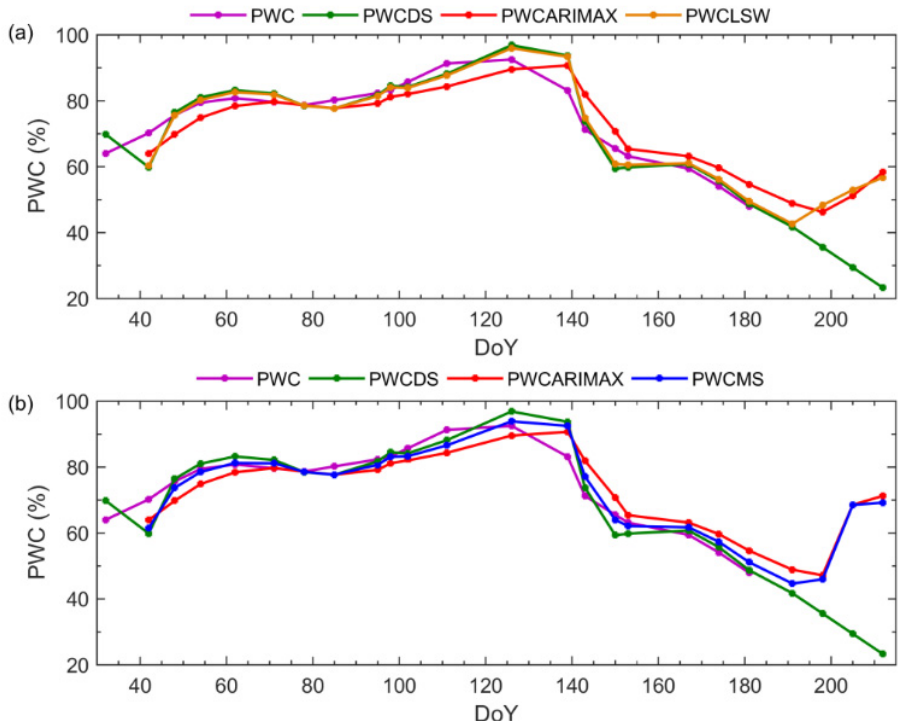
Figure 6. Combination prediction for PWC: ( a ) weighted least squares; ( b ) mean squared. PWC: interpolated data; PWCDS: double smoothing; PWCARIMAX: ARIMAX; PWCLSW: weighted least squares; PWCMS: mean squared.